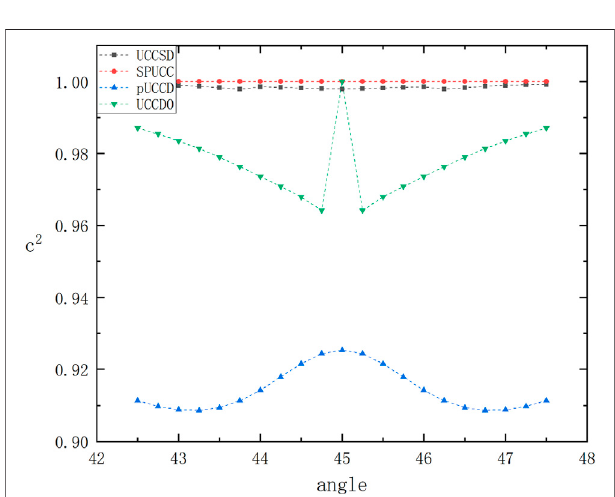
FIGURE 2 | The graph above shows the variation of the overlapping integral square of the experimental state and the exact diagonalized wave function with the circumferential angle simulated by different methods, with a maximum of